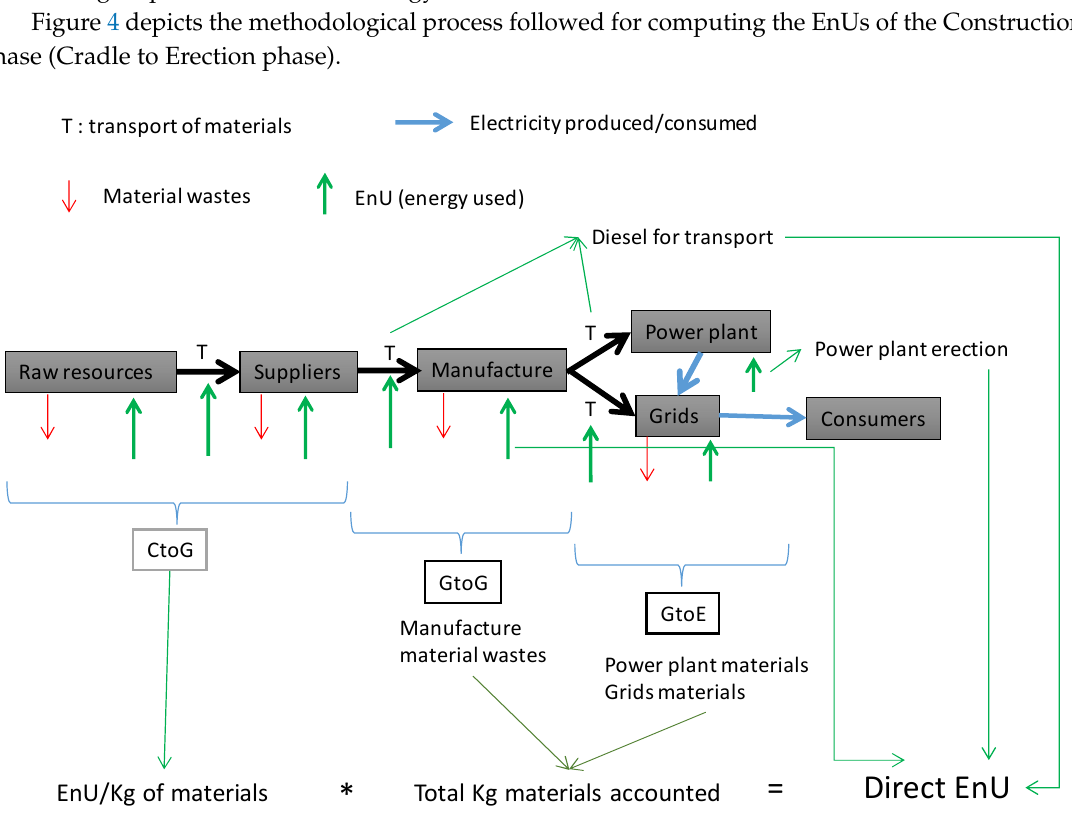
Figure 4. To estimate the direct energy used by the energy system to deliver energy (EnU direct ) we use data of energy intensities (MJ/kg) at the Cradle to Gate phase (including transport) from the materials used in the power plants and the operation and maintenance (O&M) of the grids and the losses of the manufacture phase for the material used in power plants. We add to this account the energy used in the power plant erection, the energy used in the manufacture phase and the diesel energy for transport in supplier gate to manufacture gate (GtoG) and manufacture gate to erection of the power plant (GtoE).